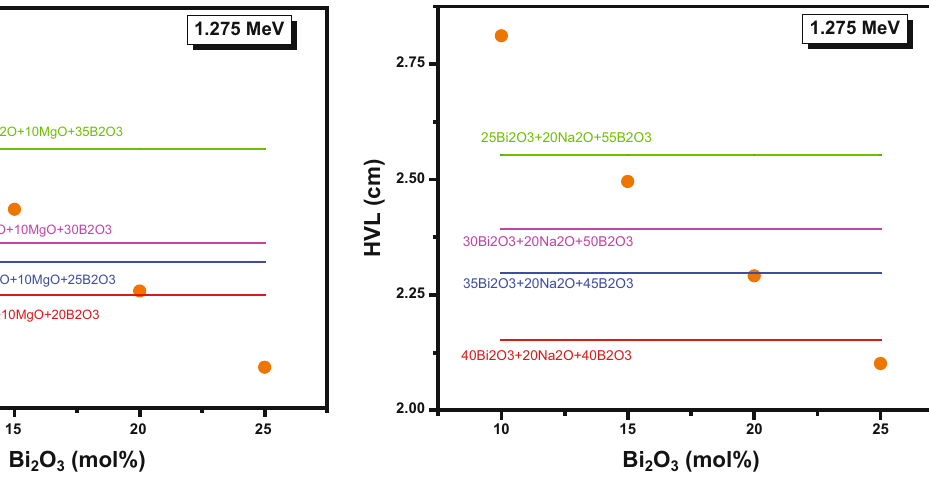
Figure 7: Comparison between the HVL for the prepared Bi 2 O 3 – PbO – CdO – B 2 O 3 glass system with the Bi 2 O 3 – Na 2 O – B 2 O 3 glass system at 1.275